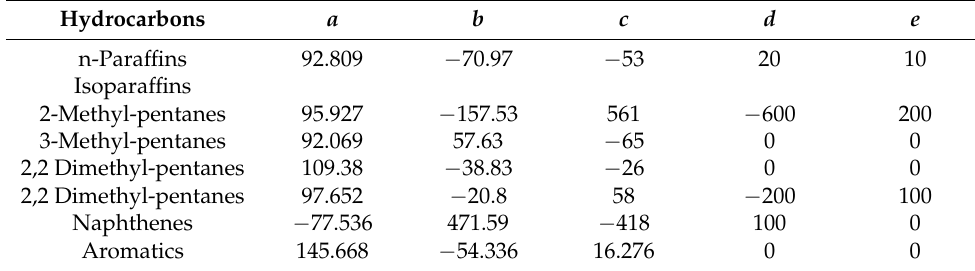
Table 10. Coefficients for RON estimation